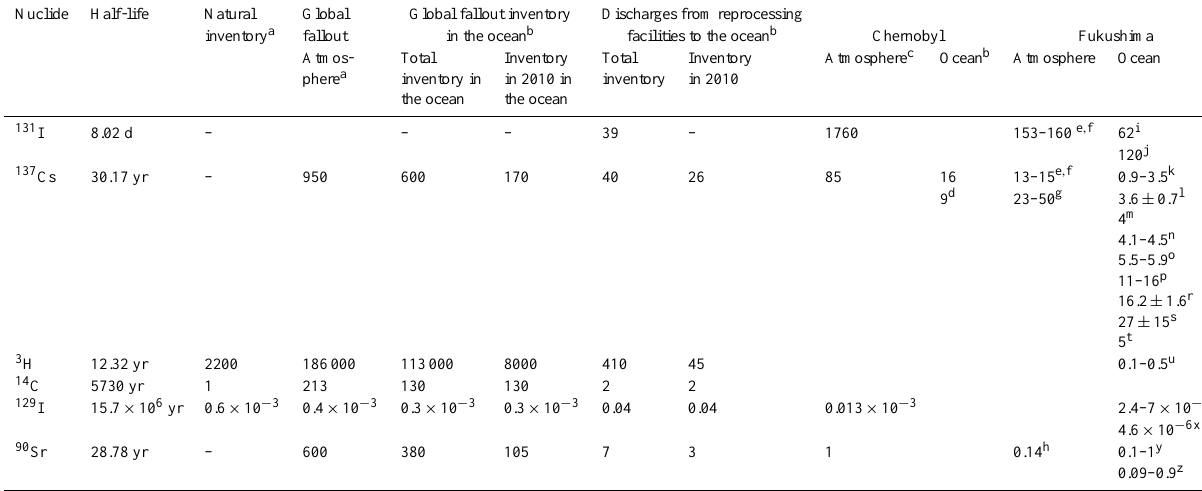
Table 1. Radionuclide inventories in the atmosphere and ocean (in PBq). Nuclide Half-life Natural Global Global fallout inventory Discharges from reprocessing inventory a fallout in the ocean b facilities to the ocean b Chernobyl Fukushima Atmos- Total Inventory Total Inventory Atmosphere c inventory in in 2010 in inventory in 2010 the